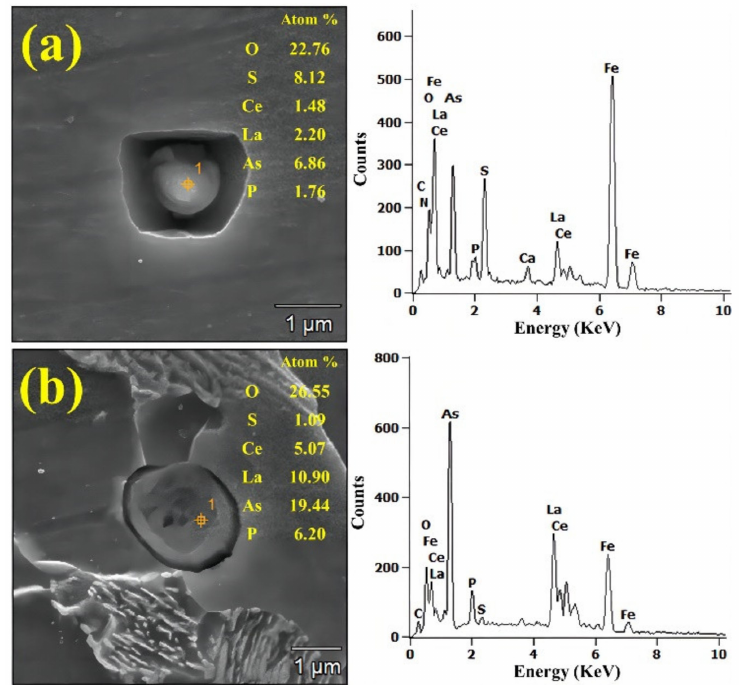
Figure 5. Morphology and type of ( a , b ) inclusions formed in 280RE